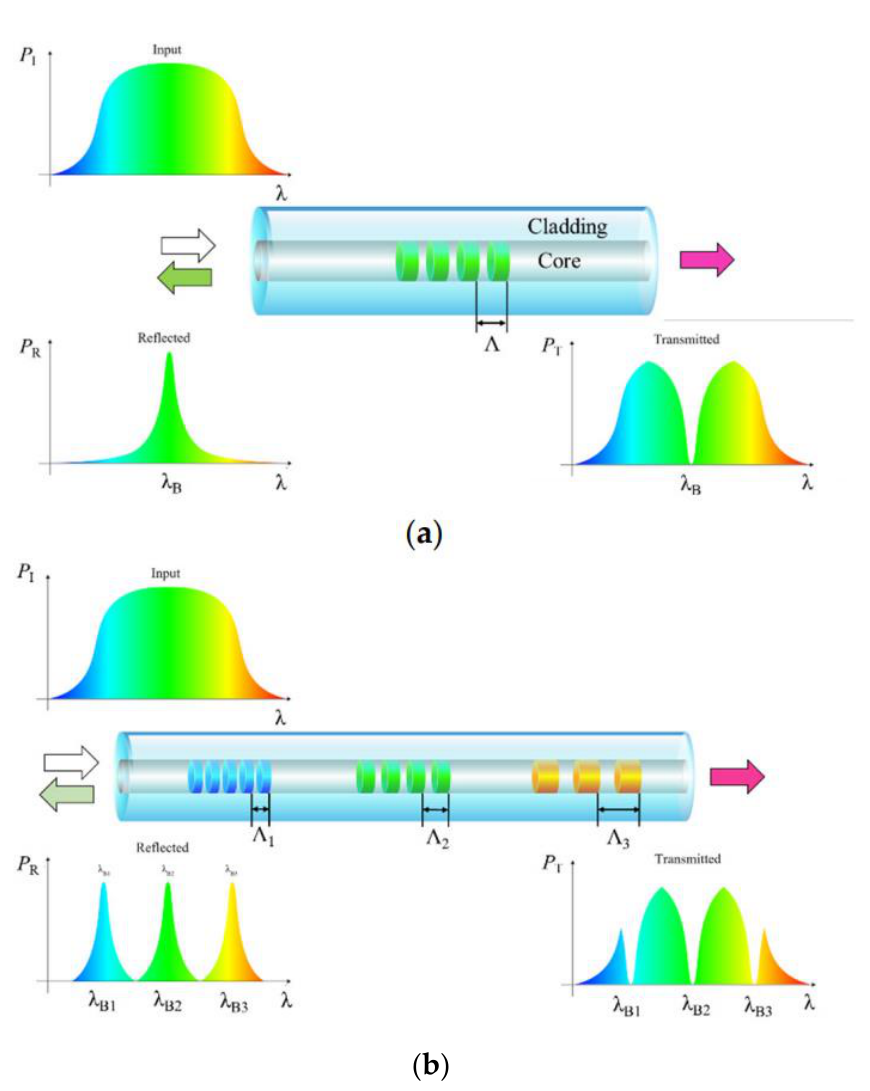
Figure 8. Optical spectral responses of ( a ) single and ( b ) multiple fiber gratings [71].